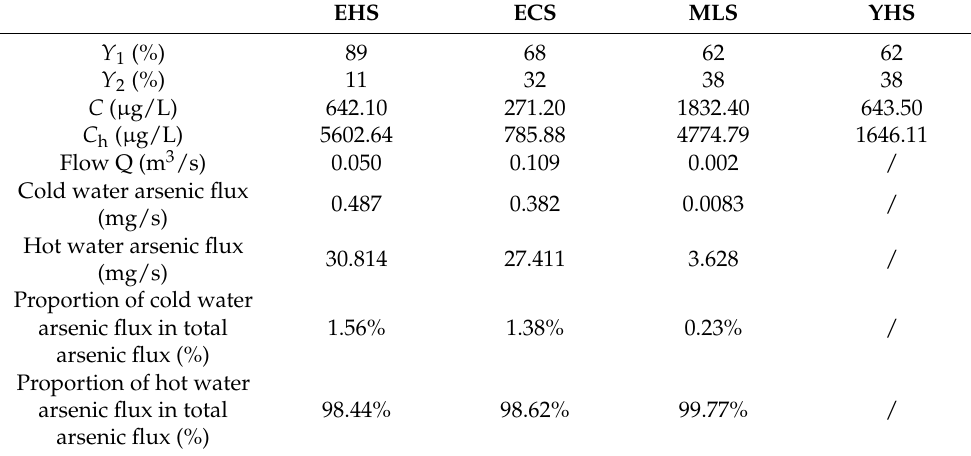
Table 6. Arsenic concentration and flux in deep geothermal